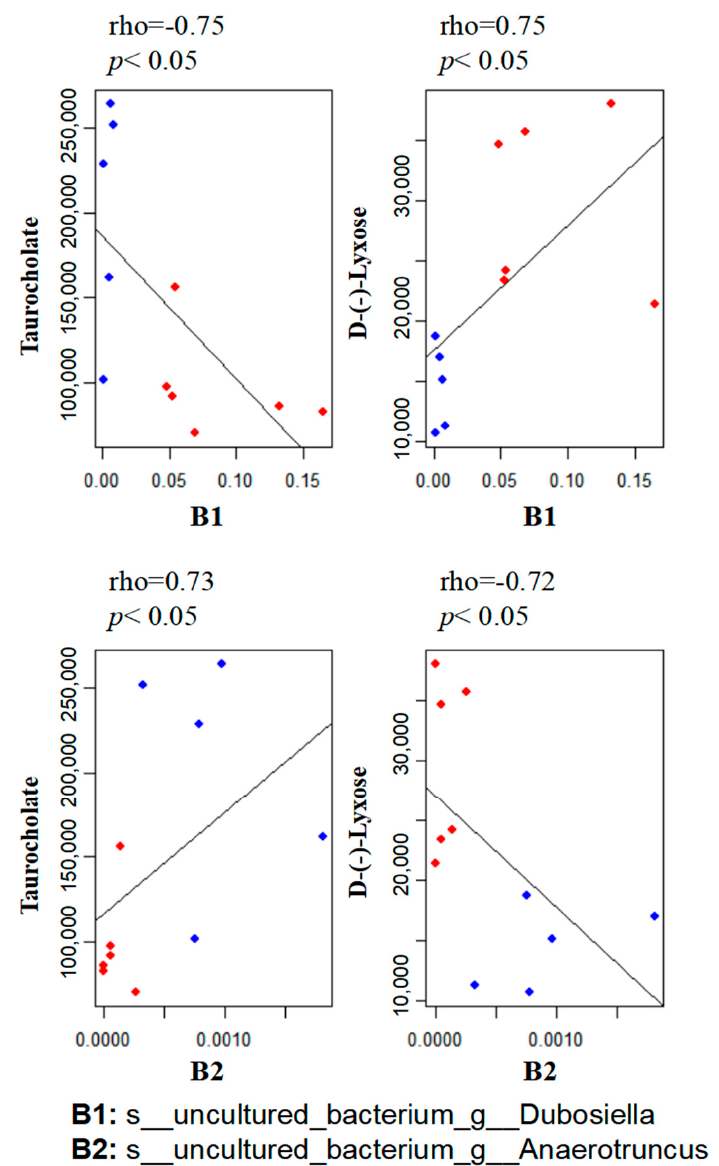
Figure 6. Scatter plots illustrating statistical associations between key metabolites and gut bacterial species (Blue dot: MP; Red dot: Control; rho > 0.7 or < − 0.7; p < 0.05).